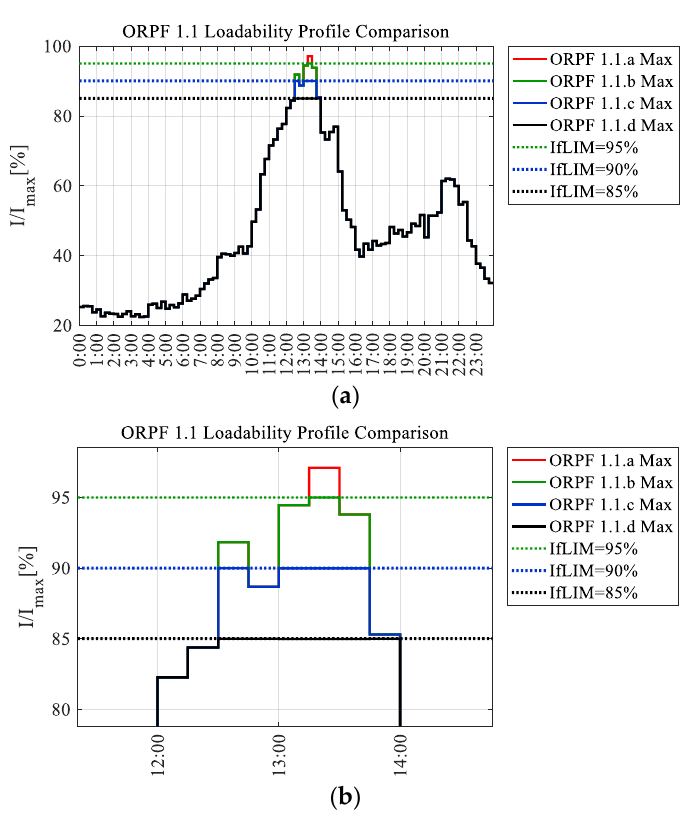
Figure 20. ORPF 1.1 loadability profile results: ( a ) full profile; ( b ) detail on photovoltaic peak hours.